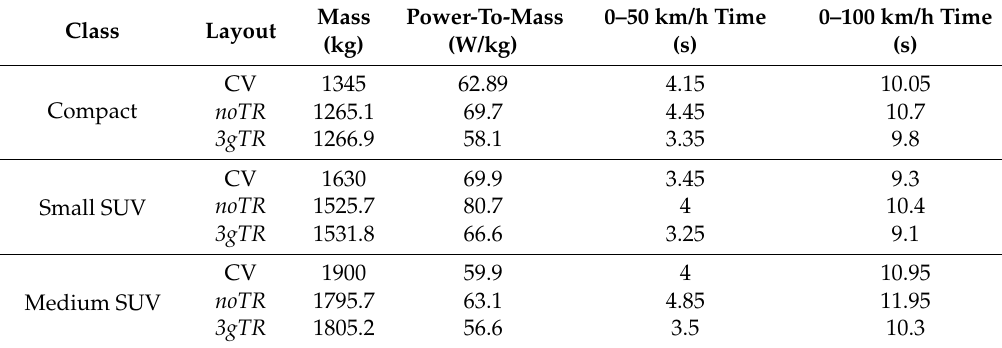
Table 8. Mass (kg) and performances of the three layouts (conventional and hybrid) for the three vehicle